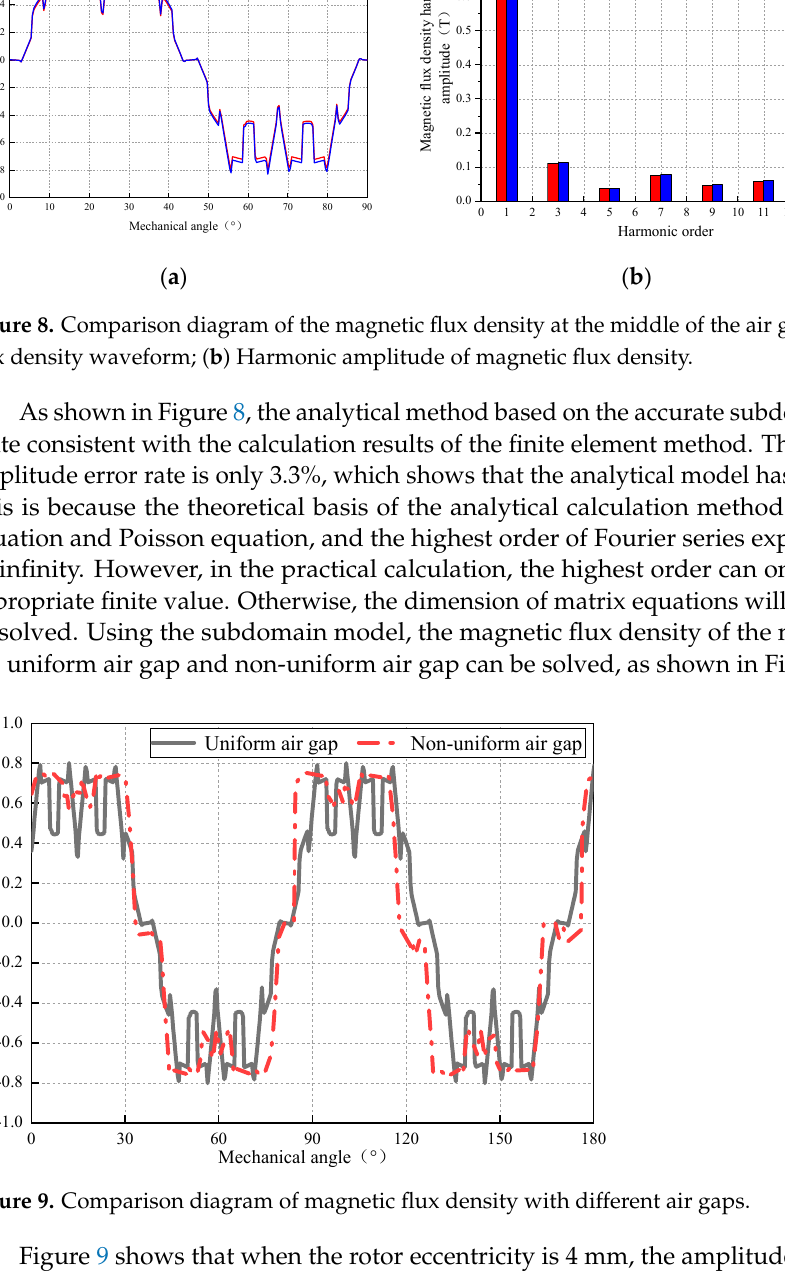
Figure 10. Comparison diagram of back EMF with different air gaps.